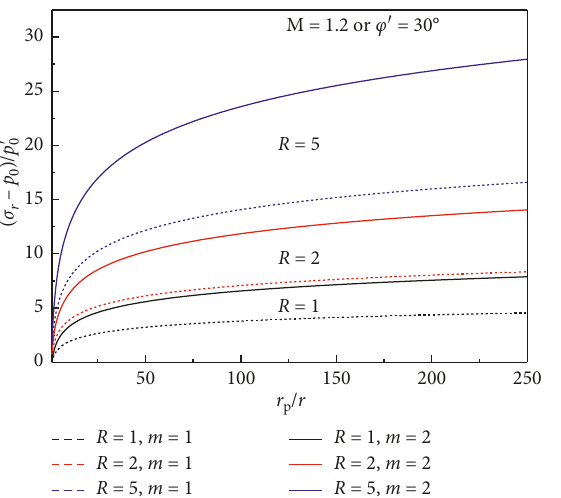
Figure 3: Relationship between normalized radial stress and radius.